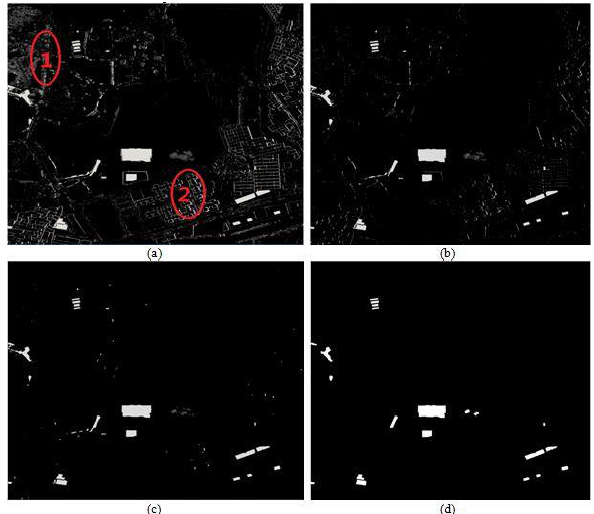
Figure 3. Filtering result of dDSM. (a) dDSM after height filtering, (b) dDSM after height texture filtering, (c) dDSM after morphological filtering, (d) dDSM after area filtering